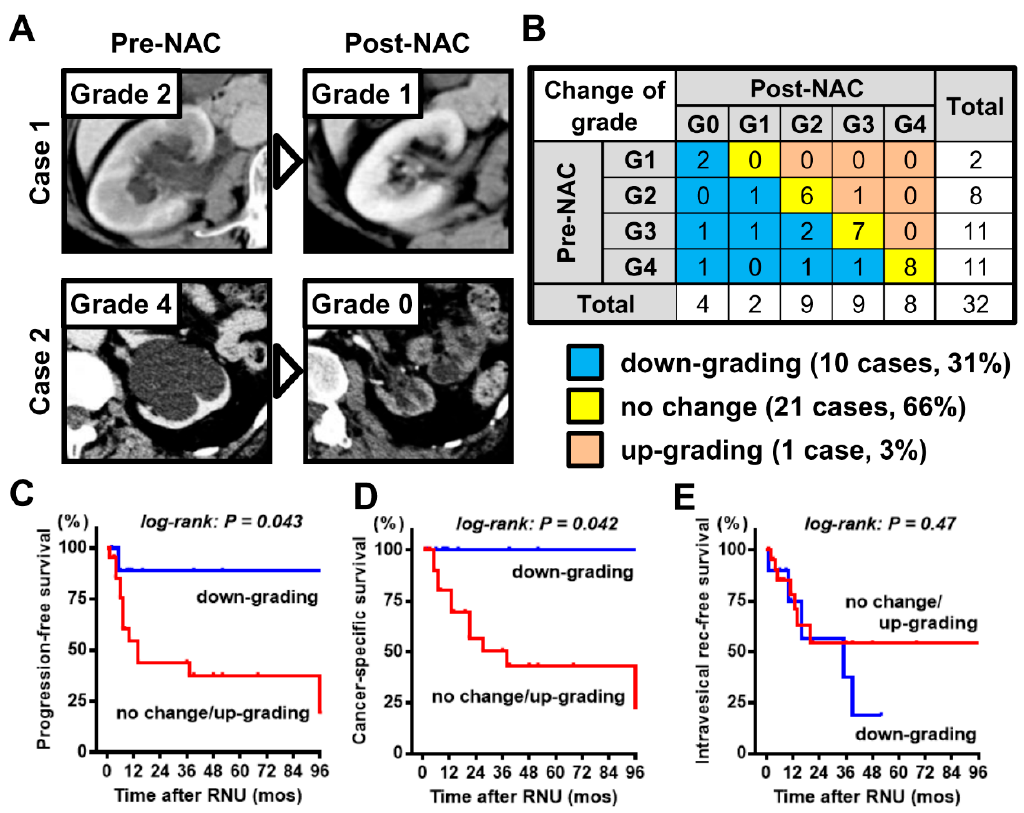
Figure 4. Association between change in hydronephrosis grade induced by NAC and the outcomes. ( A ) Representative images from two patients who experienced down-grading of hydronephrosis by NAC. Case 1: 53-year-old female patient with cT3 right ureteral tumor. Case 2: 67-year-old male patient with cT3 left ureteral tumor. ( B ) Tabulation of the changes in hydronephrosis grade induced by NAC. Curves for progression-free survival ( C ), cancer-specific survival ( D ), and intravesical recurrence-free survival ( E ) are plotted and compared according to the change in hydronephrosis grade induced by NAC (down-grading vs. no change / up-grading). NAC = neoadjuvant chemotherapy, RNU = radical nephroureterectomy.